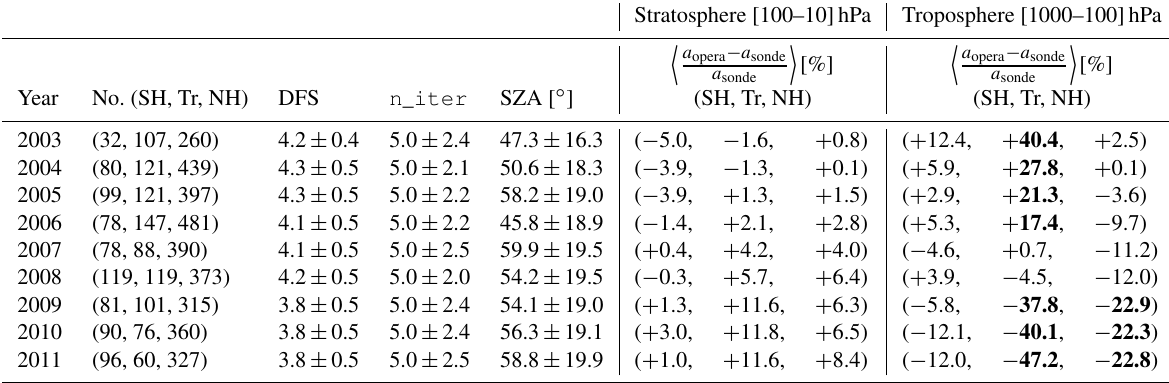
Column 1: Year. Column 2: number of states per latitude zone: Southern Hemisphere (SH), tropics (Tr) and Northern Hemisphere (NH). Column 3: median DFS. Column 4: median number of iterations. Column 5: median solar zenith angle ± standard deviation for all states in that row. Column 6: medians of relative difference between retrieved and sonde profiles for stratosphere for SH, Tr and NH over the specified altitude range and for the corresponding latitude band. Column 7: same as in Column 6 for troposphere.